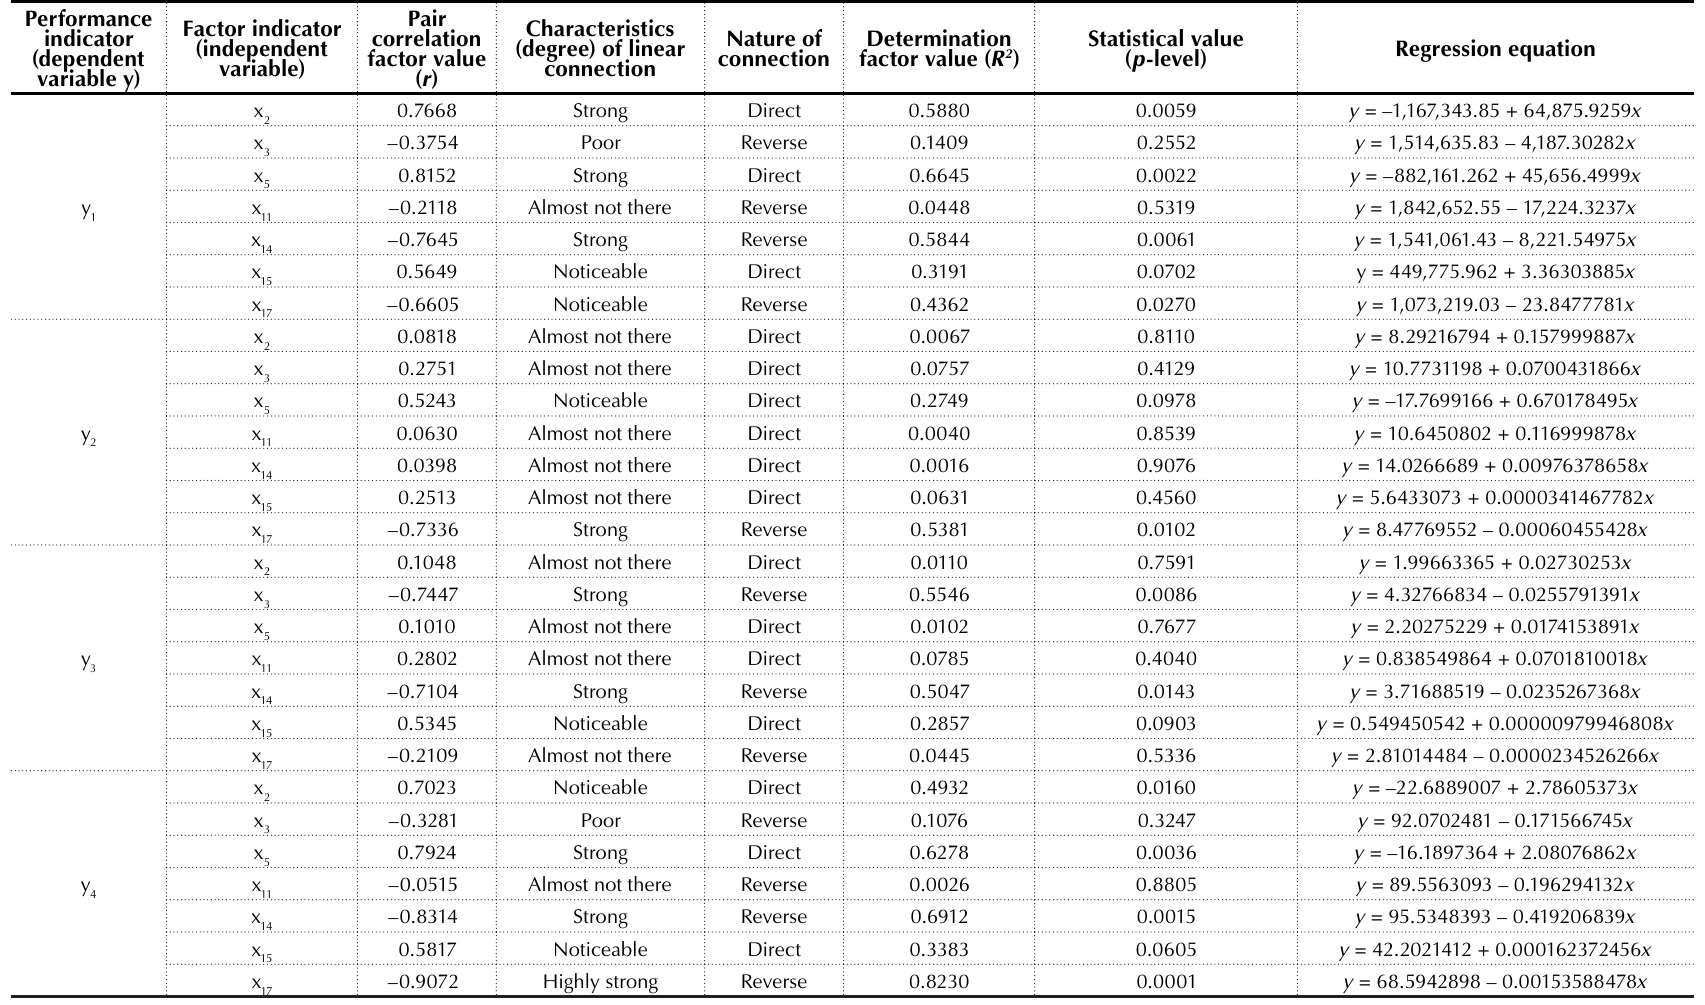
Source: Calculated by